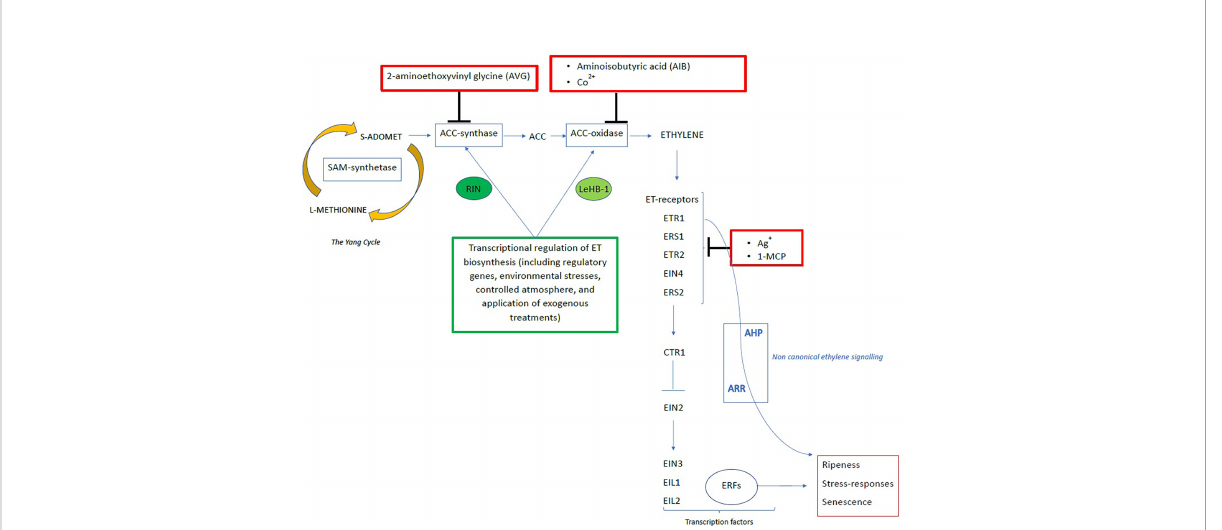
FIGURE 1 A simpli fi ed representation of the ethylene pathway including biosynthesis, signaling, and regulation (modif. Lin et al., 2009; Schaller and Binder, 2017; Binder,